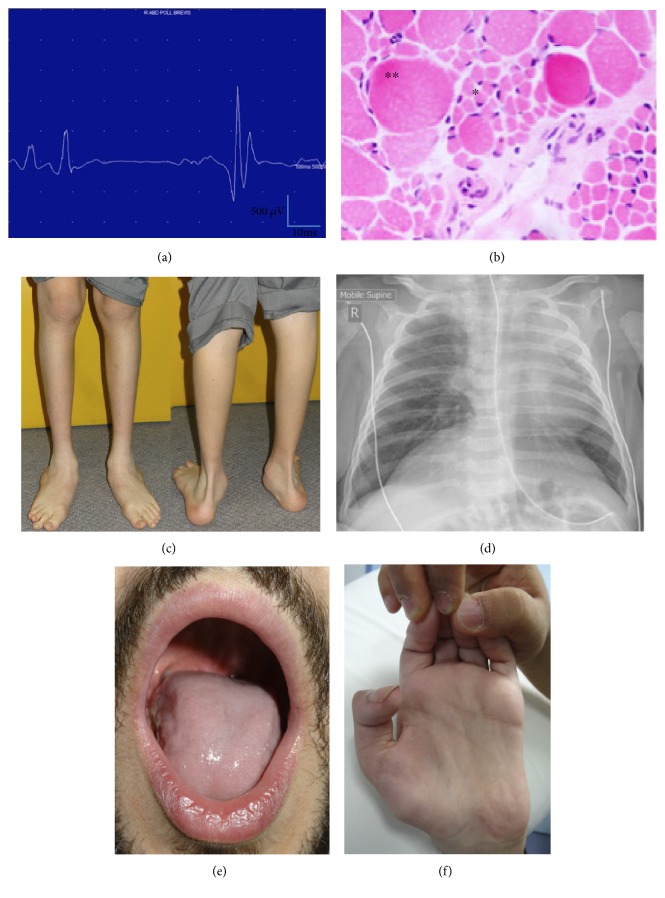
Clinical pictures of SMA plus syndrome. (a) EMG demonstrating a large-amplitude polyphasic motor unit characteristic of reinnervation. (b) H&E magnification ×200 showing small round denervated muscle fibers∗ and large hypertrophic muscle fibers∗∗. (c) Distal leg atrophy. (d) CXR showing diaphragm eventration in spinal muscular atrophy with respiratory distress (SMARD. (e) Tongue atrophy seen in Brown-Vialetto-Van Laere syndrome. (f) Hand wasting with contractures seen in Brown-Vialetto-Van Laere syndrome.